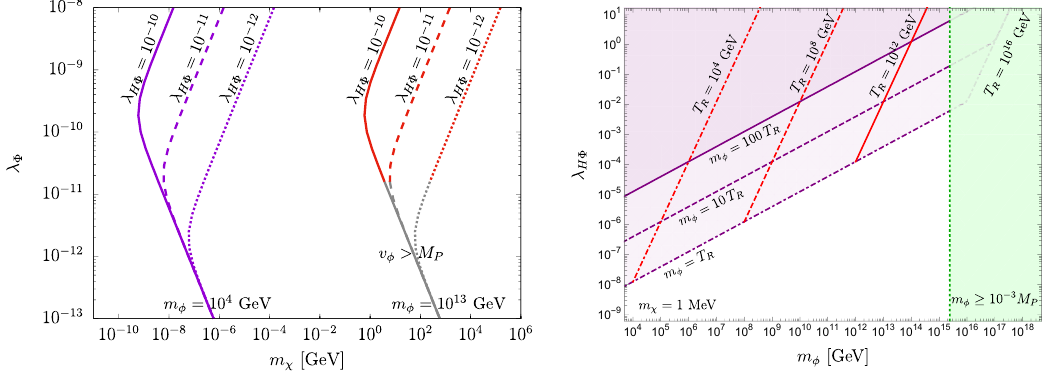
Figure 2 . Left: contours reproducing the observed relic abundance in the ( m χ , λ Φ ) plane where the mediator mass is fixed to be m = 10 4 GeV ( 10 13 GeV ) in the purple (red) line. The solid, φ dashed and dotted lines correspond to λ = 10 − 10 , 10 − 11 and 10 − 12 , respectively. The gray parts H Φ of the red lines are excluded by the criterion v . Right: the purple region can realize the φ > M P observed relic abundance via the UV freeze-in in the ( m ) plane. Each contour reproduces the φ , λ H Φ abundance for a specific parameter set. The solid, dashed and dot-dashed red lines correspond to T R = 10 12 GeV , 10 8 GeV and 10 4 GeV , respectively. The green region, m φ ≥ 10 − 3 M P , is excluded (see the